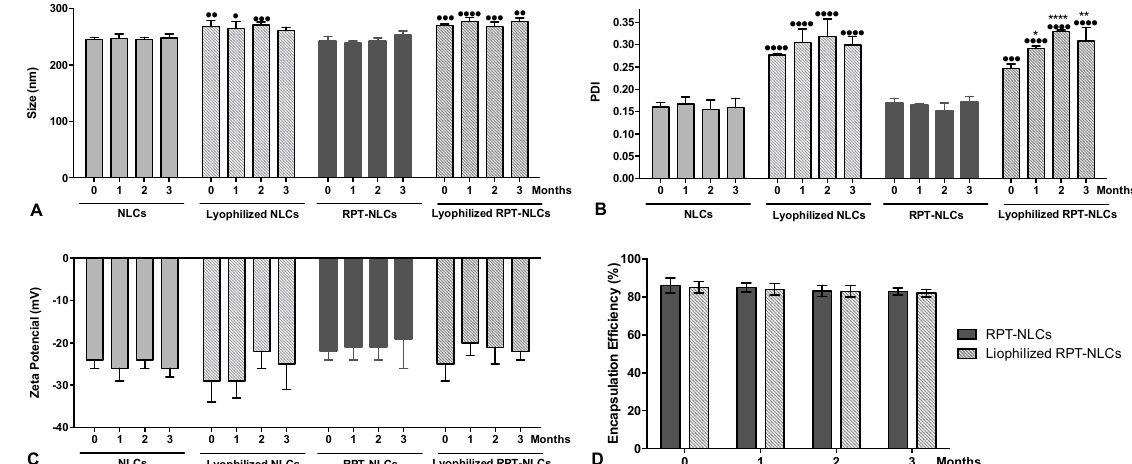
Figure 3. Storage stability of ( A ) particle size, ( B ) polydispersity index (PDI), ( C ) zeta potential, and ( D ) encapsulation efficiency of the lyophilized and liquid suspension nanoparticles during 3 months of storage at 20 °C. Data expressed as mean ± SD (n = 3). Statistical comparisons of the means were performed using the two-way analysis of variance and differences between groups compared using Tukey’s multiple comparisons test. * p < 0.05; ** p < 0.01; **** p < 0.0001 compared with the corresponding T0 (measurement after synthesis). • p < 0.05; •• p < 0.01; ••• p < 0.001; •••• p < 0.0001 compared with the corresponding placebo at the same time-point.